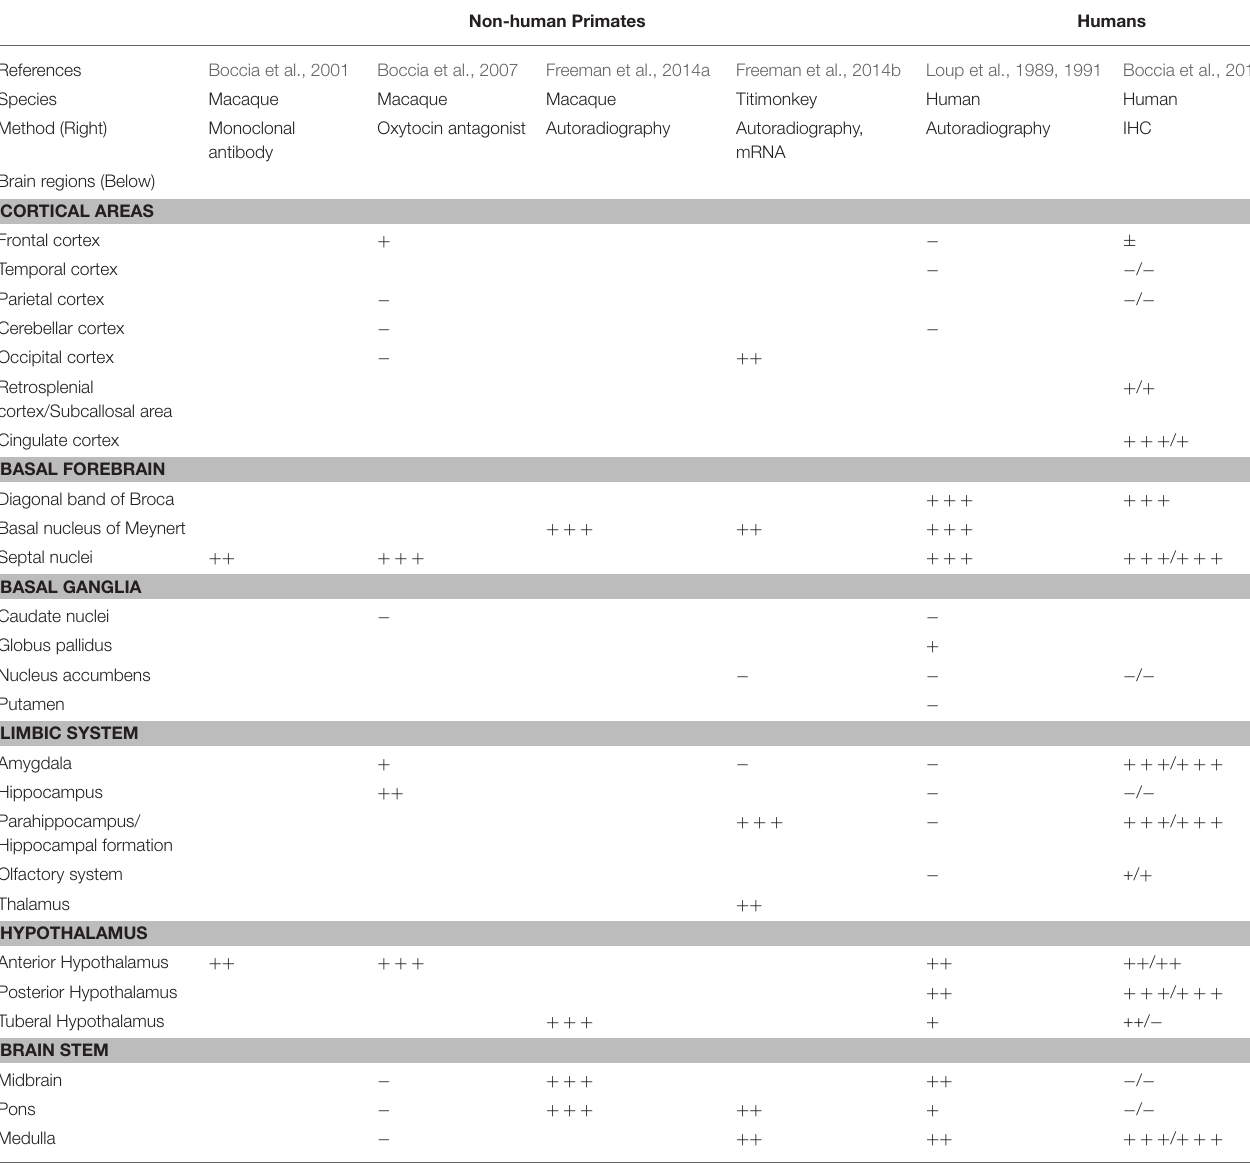
TABLE 1 | Distribution of oxytocin receptors in the central nervous